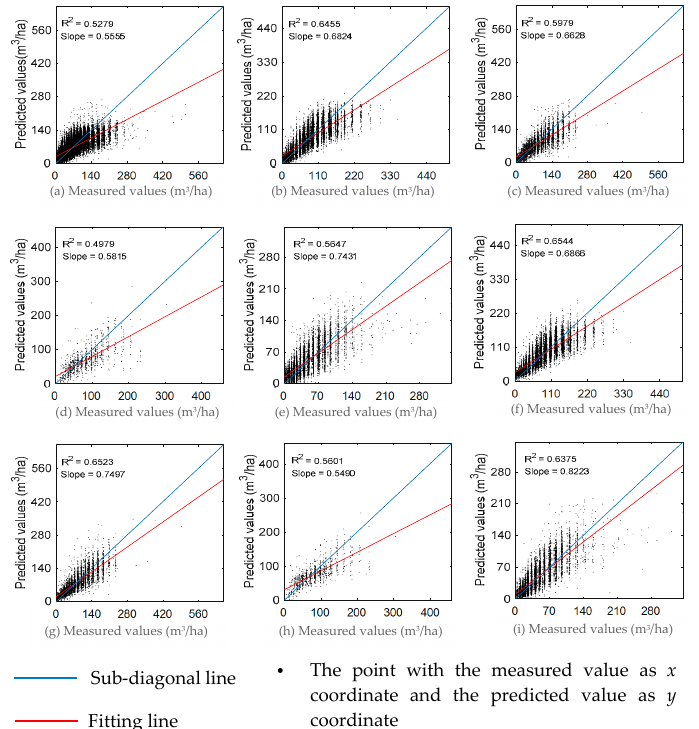
Figure 2. Scatter plots between predicted values and measured values for Schemes 1, 2 and 3. Subgraph ( a ) represents Scheme 1 with mixed dominant tree species; subgraphs ( b – e ) represent Scheme 2 for Chinese fir, Masson pine, Taiwan pine, and hard broadleaves, respectively; and subgraphs ( f – i ) represent Scheme 3 for Chinese fir, Masson pine, Taiwan pine, and hard broadleaves,